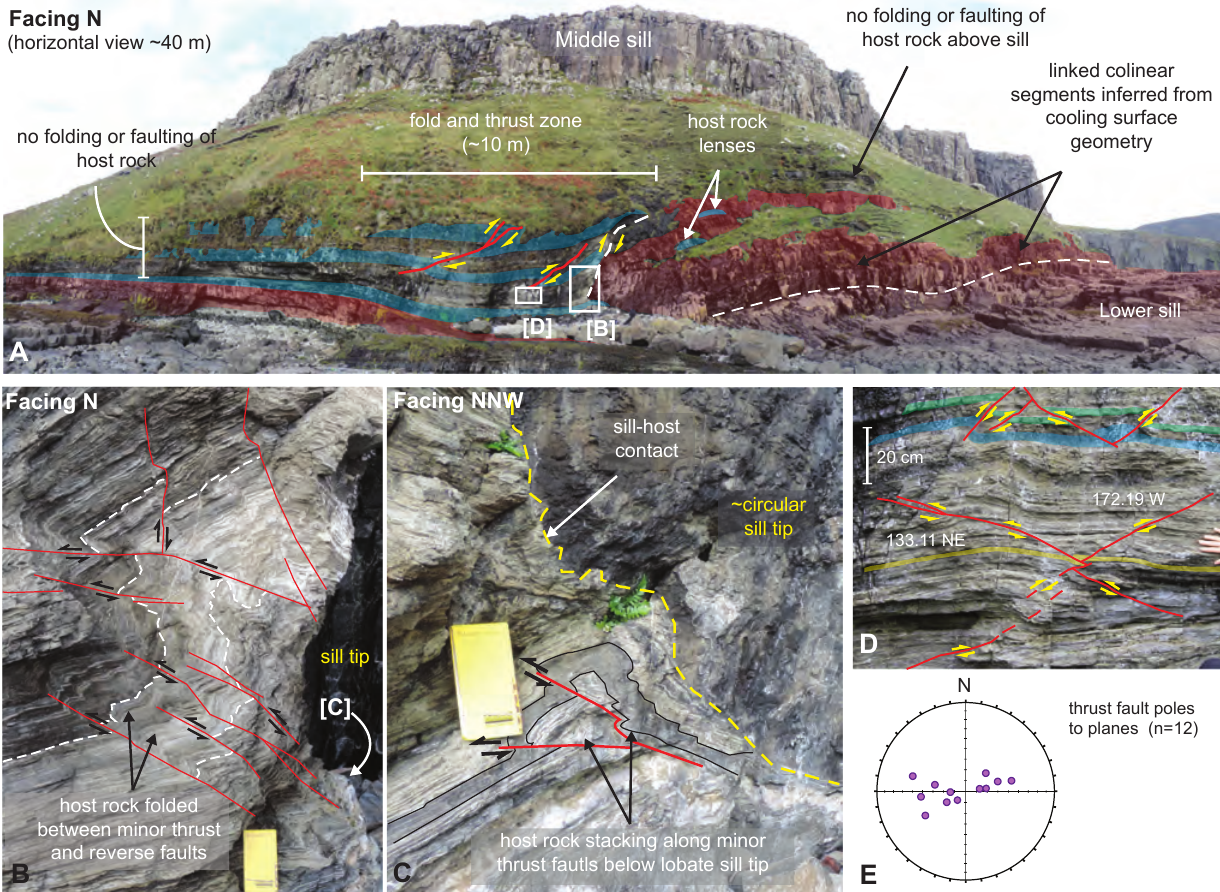
Figure 9: (Previous page.) Examples of underlapping segment arrays in the Neist Point study area. [A]–[B] Off- set underlapping segments with elliptical to squared ellipse geometries in laminated sandstone: [A] segments have chilled margins; brecciated and fractured host rock occurs ahead of each tip and within the relay zone. [A] Brecciation and loss of host rock structure within the relay zone. [C] Offset segments in mudstone, segments are labelled A–C. Underlapping segments display squared ellipse tips with magma fingers (A) and sharp ellipse (B) geometries. Offset overlapping linked segments (B–C) display tapered (wedge-shape) tips. [D]–[F] Examples of underlapping collinear segments in mudstone, their position in the array is shown on the sketch. [D] Elliptical (E) to circular (F) tip geometries, the zone of lighter coloured structureless host rock is localised about each tip; magma fingers protrude from the segment tips into the structureless zone. [E] Elliptical (F) to squared ellipse (G) tip geometries, magma fingers protrude from the segment tips into the structureless underlap zone. [F] squared ellipse (H) and circular (I) tip geometries magma fingers protrude from the segment tips into the structureless underlap zone. (Unannotated photos available in Supplementary File 1).